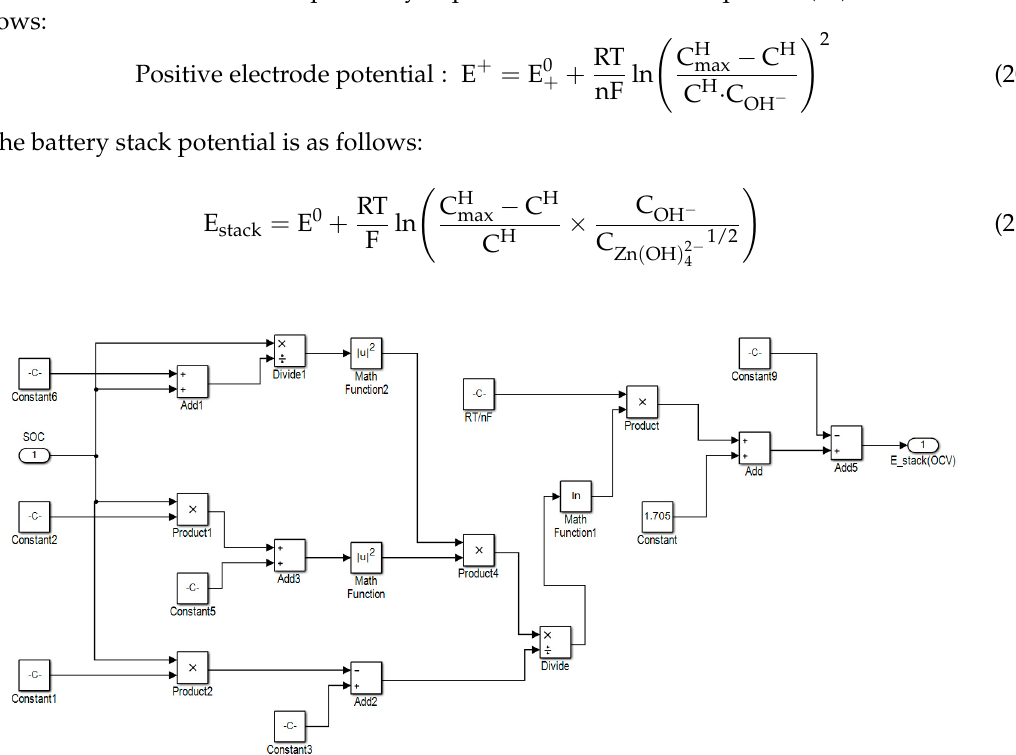
Figure 5. Open-circuit voltage estimation model of zinc–nickel single-flow battery stack.